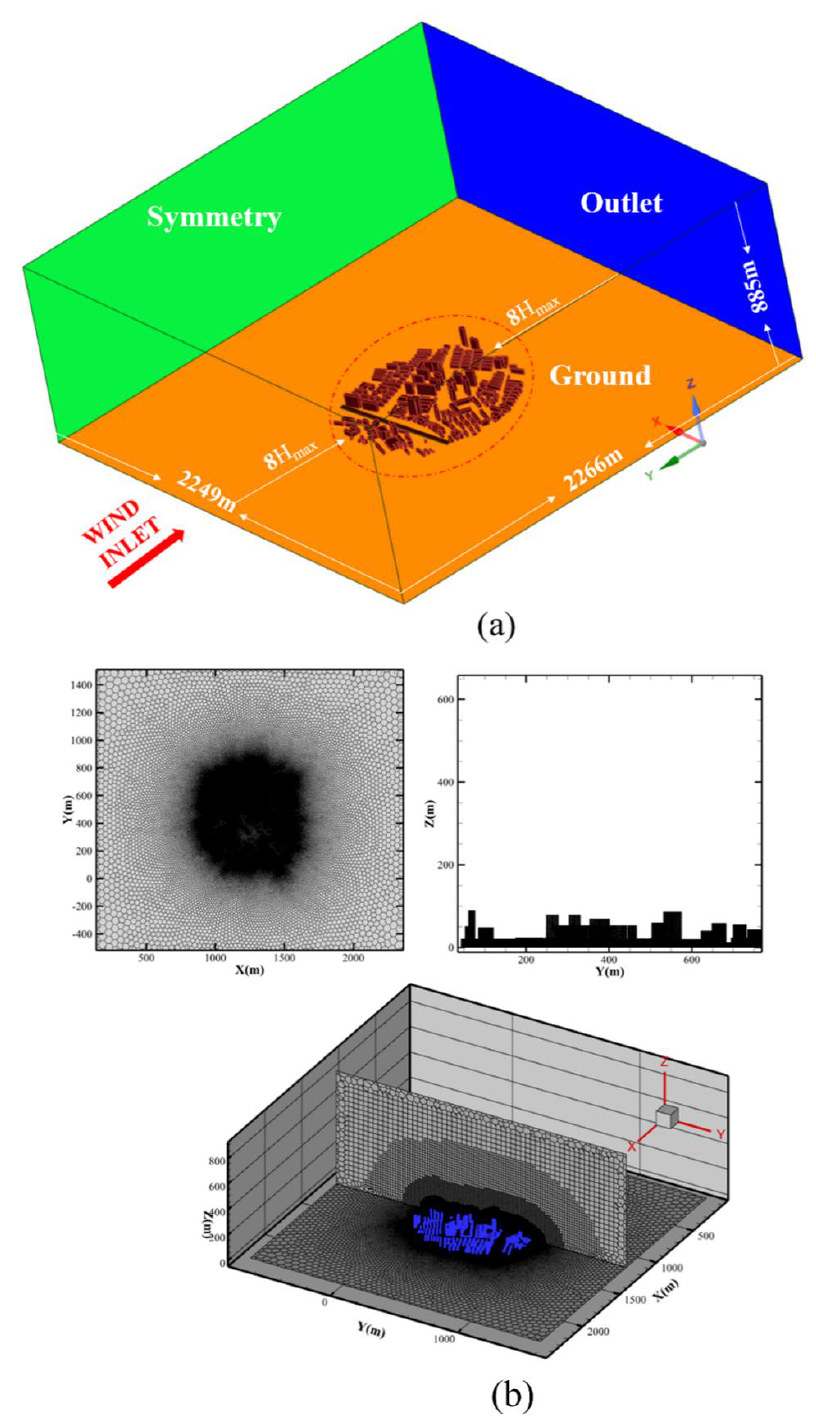
Figure 2. Analysis model. ( a ) Space claim model, computational domain extent; ( b ) Computational mesh of target urban area on ground and city district, a high degree of refinement is applied for street lanes and for the whole street canyon, which are the main subjects of this